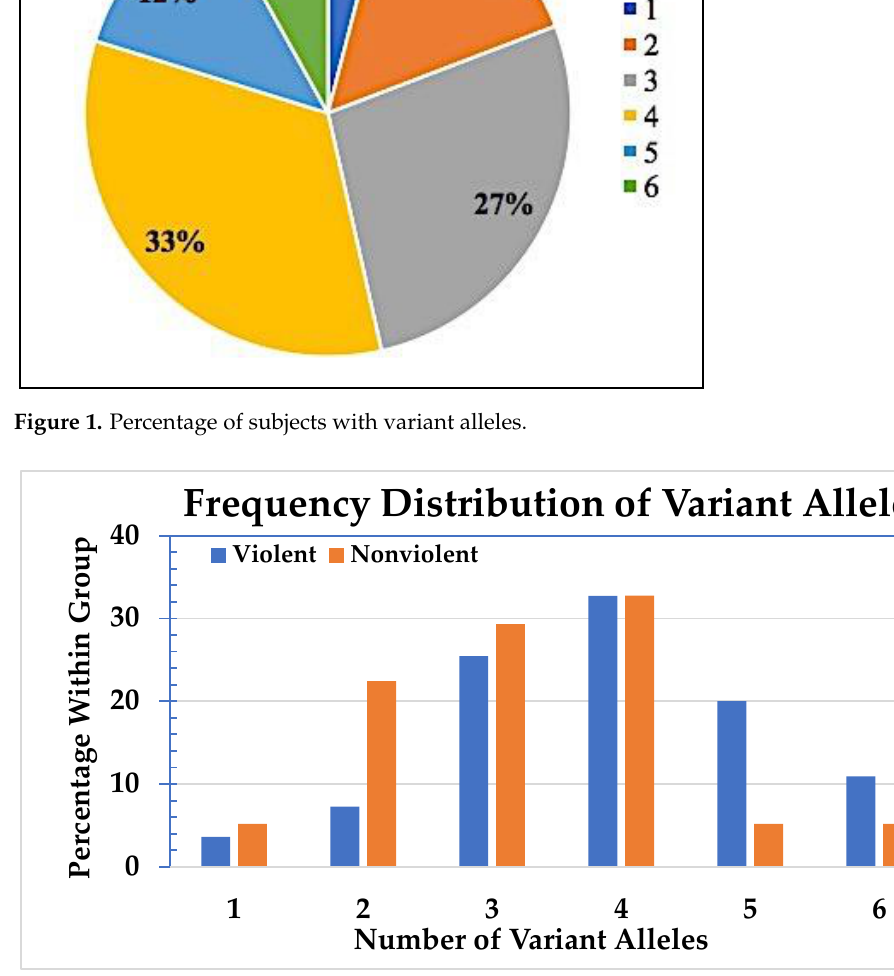
Figure 2. Percentage of subjects with 1 – 6 variant alleles. Because of the low cell numbers, the subjects with one and two variant alleles were combined, as were those with five or six. The distribution of variant alleles in the groups is significantly different ( p = 0.018). To emphasize this difference, a Chi-square test was conducted with all the cells with less than five variant alleles being summed, and the cells with five and six being summed. The result supports the hypothesis that having five or six variant alleles affects the likelihood of violent behavior (odds ratio 3.88; 95% CI: 1.40–10.76; p = 0.007). There are significantly more individuals with five or six variant alleles in the violent group compared to the nonviolent group.